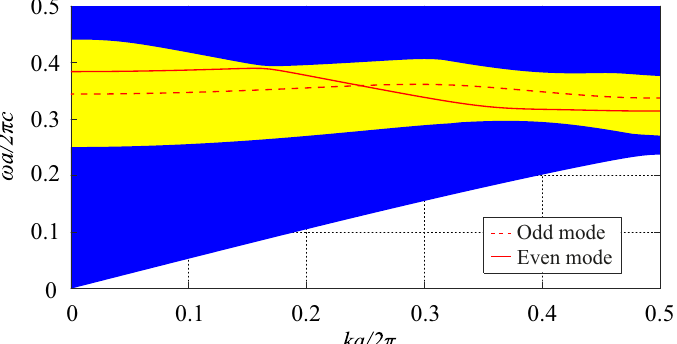
Figure 3. Dispersion diagram of the PhC W1